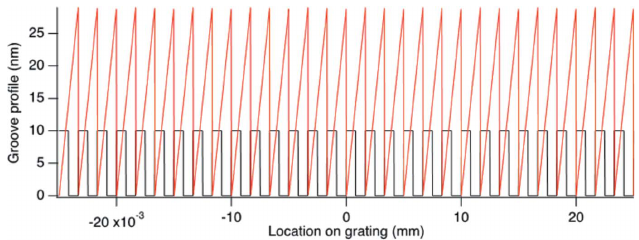
Figure 5 Groove profiles in the center of the grating with D 0 = 600 l/mm, D 1 = 0.4 l/mm 2 and D 2 = 4 (cid:5) 10 (cid:2) 5 l/mm 3 . The black curve is for a laminar grating with 10 nm depth. The red curve is for a blazed grating with a 1 (cid:8) blaze angle.